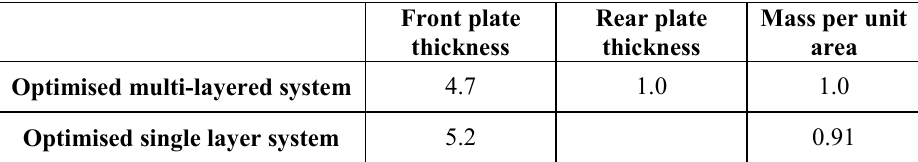
Table 3. Optimisation results (normalised